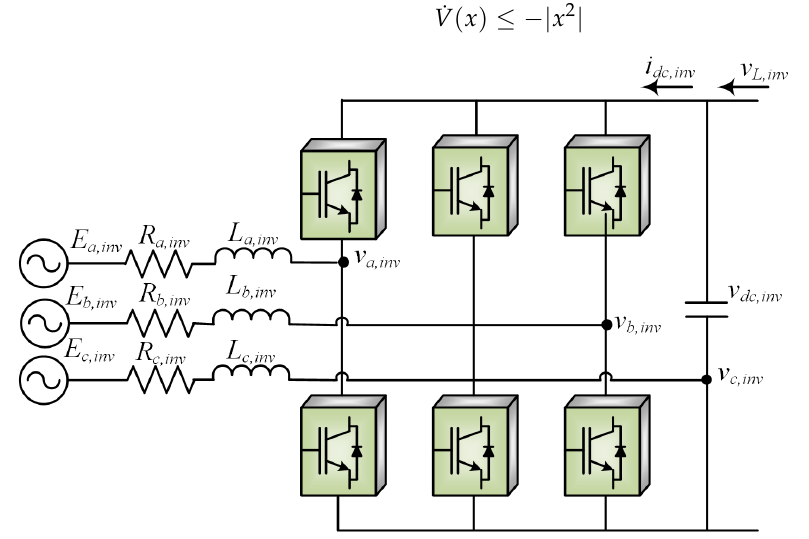
Figure 6. Interlinking Voltage source converter